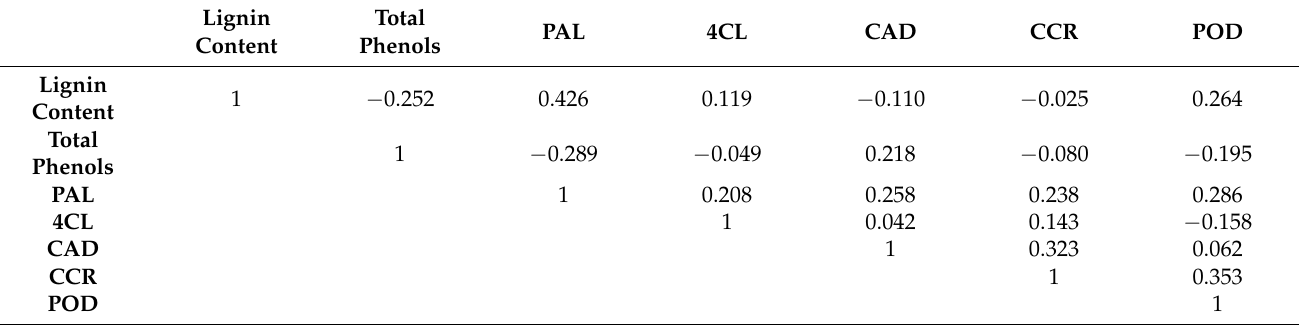
Table 1. Correlation analysis of lignin content, total phenol and enzyme